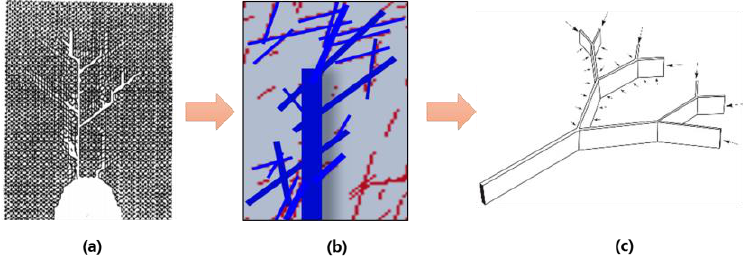
Figure 3. Multi-stage fractured horizontal well with representative element volume (dark area).